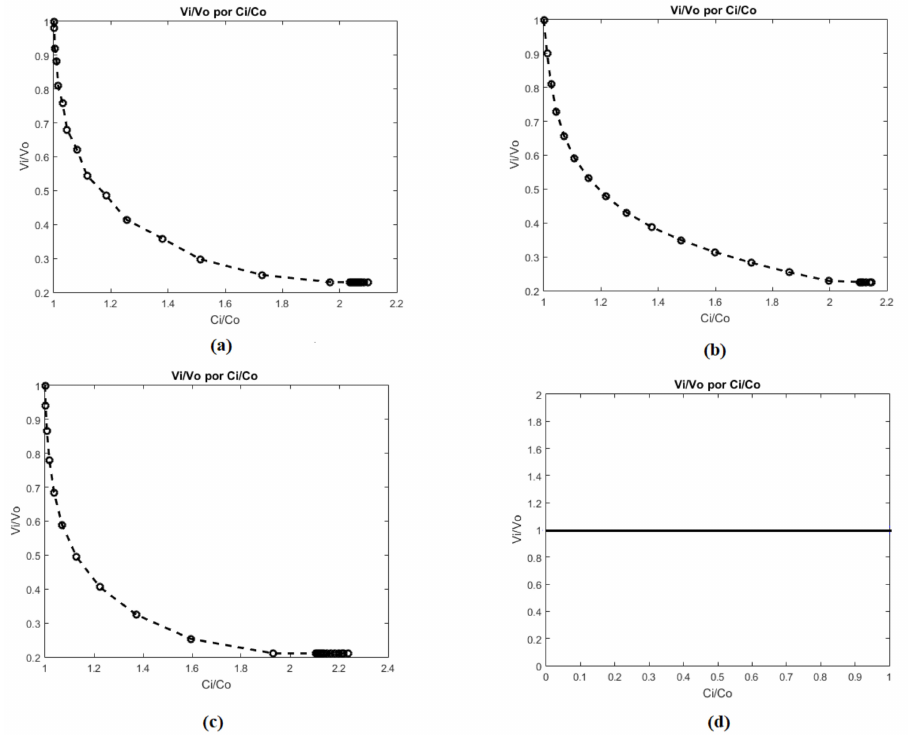
Figure 11. Performance characteristic curve for structures with compliance constraints: ( a ) ESO, ( b ) SERA, ( c ) SESO and ( d )